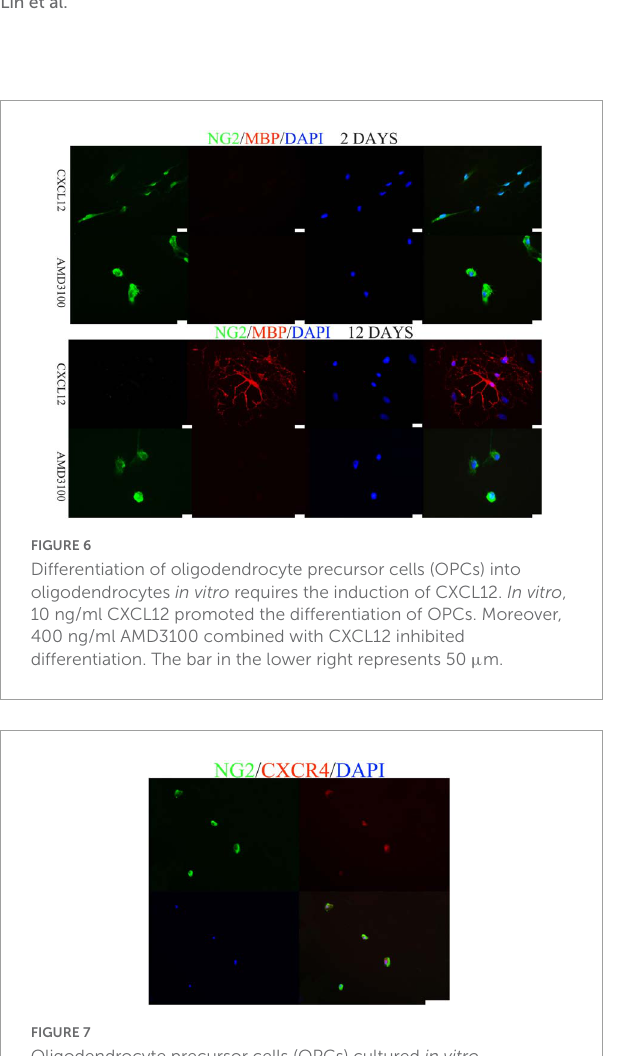
FIGURE7 Oligodendrocyte precursor cells (OPCs) cultured in vitro coexpressed CXCL12 and its receptor CXCR4. The bar in the lower right represents 50 µ